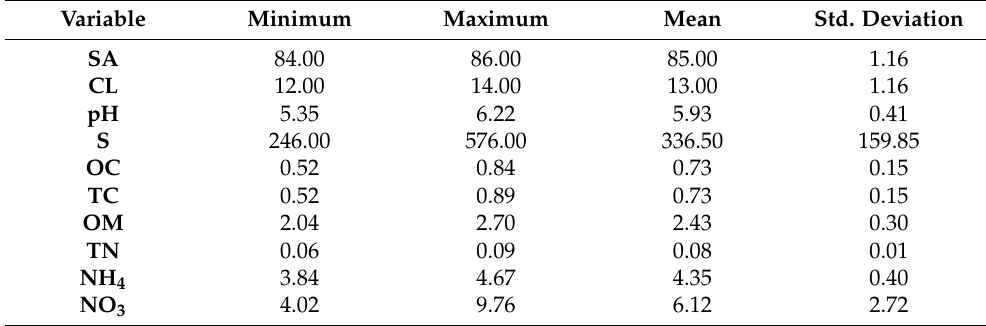
Table 1. Physio-chemical parameters of the maize